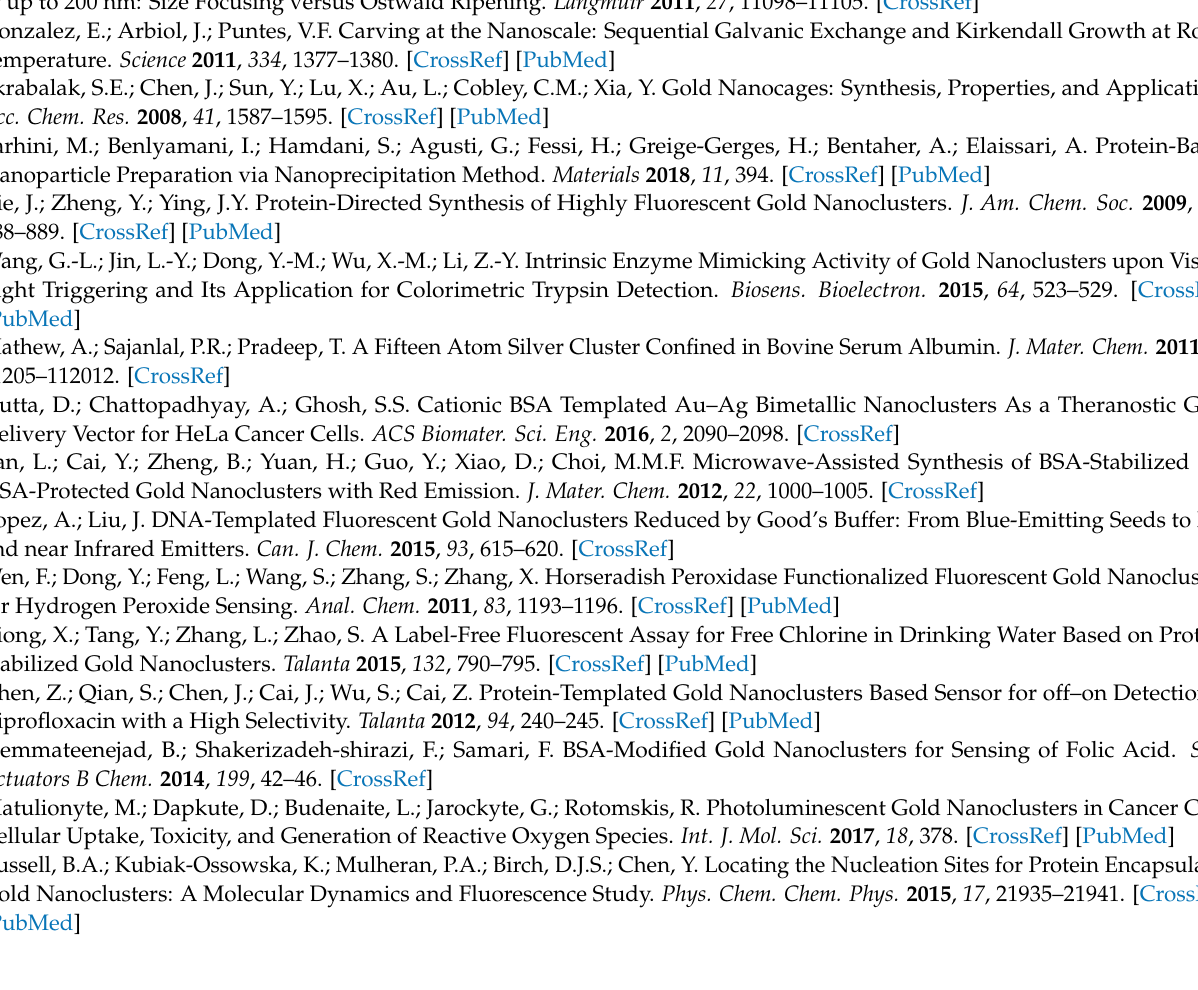
Figure S2: UV/Vis spectrum and excitation spectrum of RS AuNC@BSA; Table S1: Lifetime data obtained by measuring the lifetime decay of RS AuNC@BSA at 273 K at different pH values; Figure S3: Fluorescent emission data of HSA upon titration with STC; Figure S4: Fluorescent emission data of BSA upon titration with FB 1